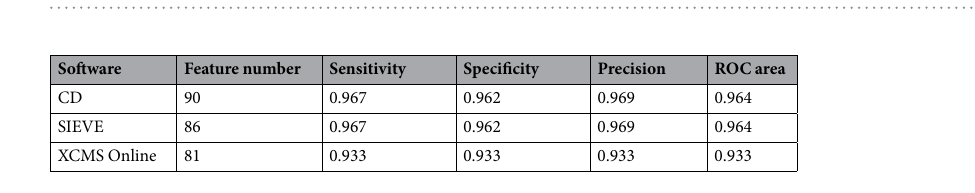
Table 1. Binary classification performance of candidate biomarkers to differentiate preclinical AD and control groups using three software